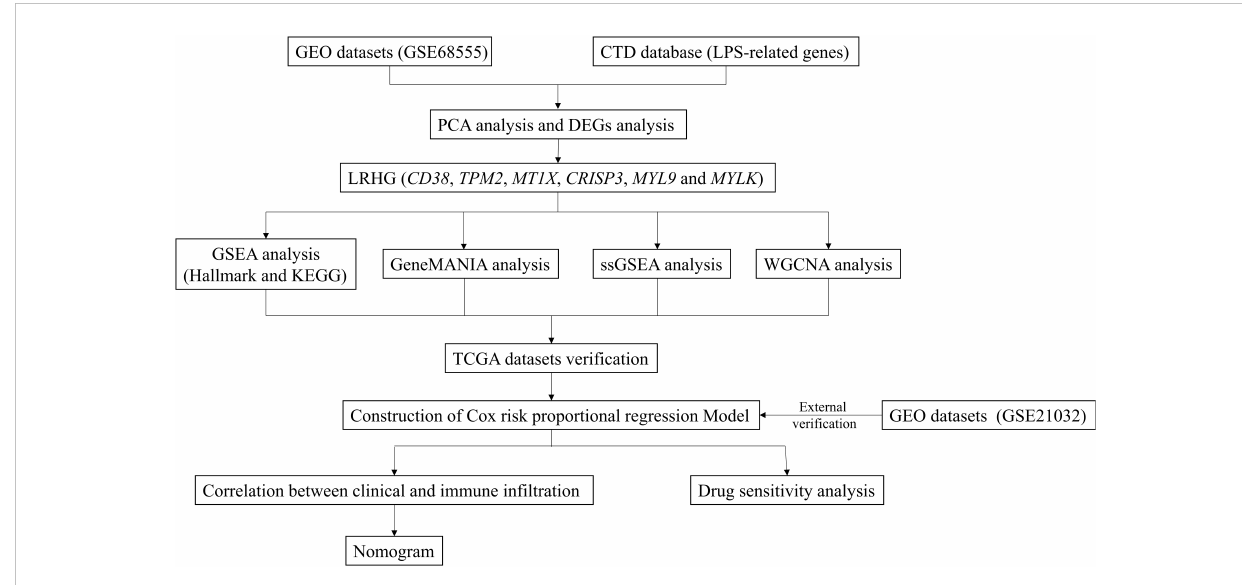
FIGURE 1 The fl owchart of data collection and